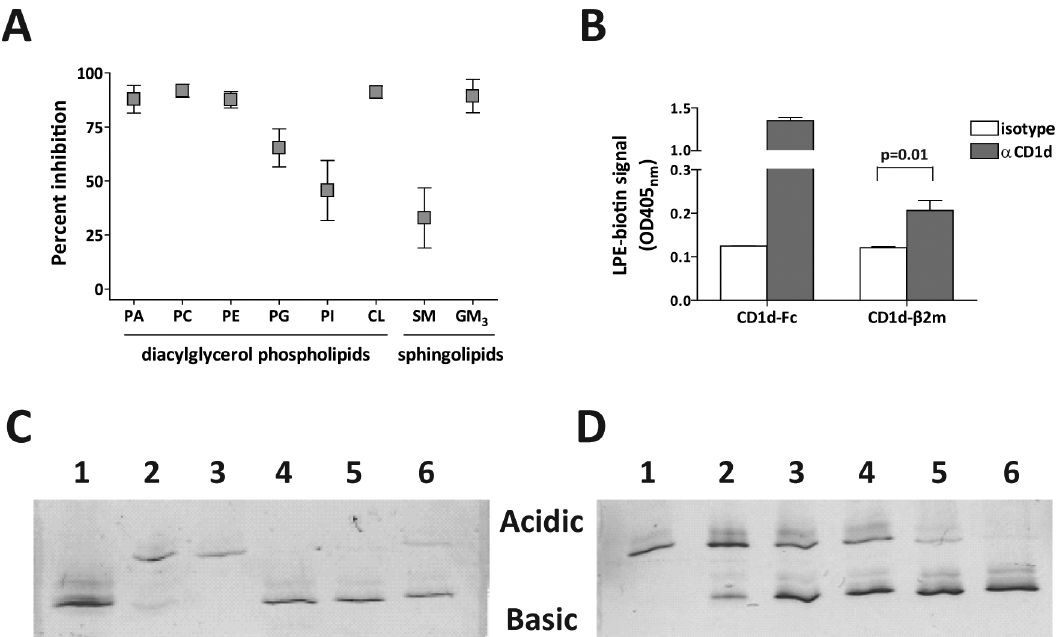
Figure 5. Effect of bound lipids on CD1d antigen loading. (A) Immobilized CD1d molecules were preincubated with the indicated lipids or treated with vehicle alone for 24 h. Unbound lipids were washed away, and the CD1d molecules were incubated with the a -GSL C20:2 for 24 h, then tested for the ability to stimulate NKT cell cytokine secretion. Percent inhibition was calculated by comparing NKT cell cytokine secretion in response to C20:2 pulsed onto CD1d molecules pretreated with lipid compared to CD1d pretreated with vehicle alone. The plot shows means and standard deviations of results compiled from seven independent experiments. (B) Biotinylated LPE (15 m M) was incubated with CD1d-Fc fusion protein or with secreted CD1d- b 2m heterodimers that contain a mixture of bound ligands [25]. The samples were then incubated on plates coated with an anti-CD1d mAb (filled bars) or with an isotype-matched negative control mAb (open bars), and bound LPE was detected using a streptavidin-enzyme conjugate. OD450 nm , optical density at 450 nm. (C) Native isoelectric focusing (IEF) analysis of lyso-phospholipid binding to recombinant CD1d molecules. Purified native CD1d molecules were mock-treated (lane 1), or preloaded with the trisialoganglioside GT1b (lanes 2–6), then incubated in solution with free lipids and separated by electrophoresis according to charge. Lane 3 shows GT1b-CD1d incubated with additional GT1b; lane 4 shows GT1b- CD1d incubated with a 4.5-fold molar excess of a -GalCer; lane 5 shows GT1b-CD1d incubated with a 3-fold molar excess of LPC; and lane 6 shows GT1b-CD1d incubated with a 3-fold molar excess of LPE. (D) Titration of the amount of lyso-phospholipid required to displace bound GT1b. Lane 1 shows GT1b-CD1d incubated in buffer with no LPE; lanes 2–6 show GT1b-CD1d incubated with the following molar ratios of LPE: lane 2=1:1, lane 3=1:2, lane 4=1:3, lane 5=1:5, and lane 6=1:9.